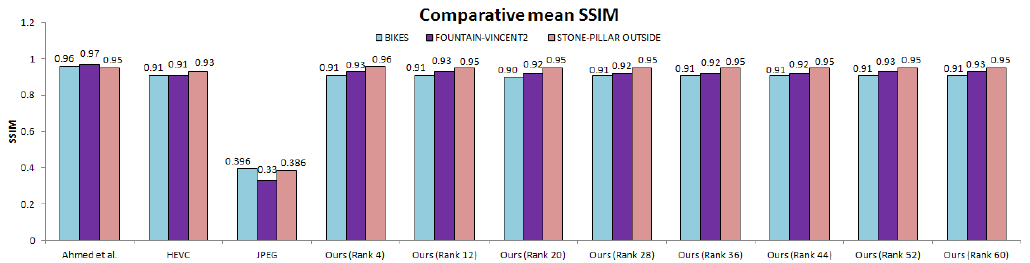
Figure 13. Comparative mean SSIM for the proposed scheme and anchor coding methods. Average SSIM was computed over all 169 views and all quantization